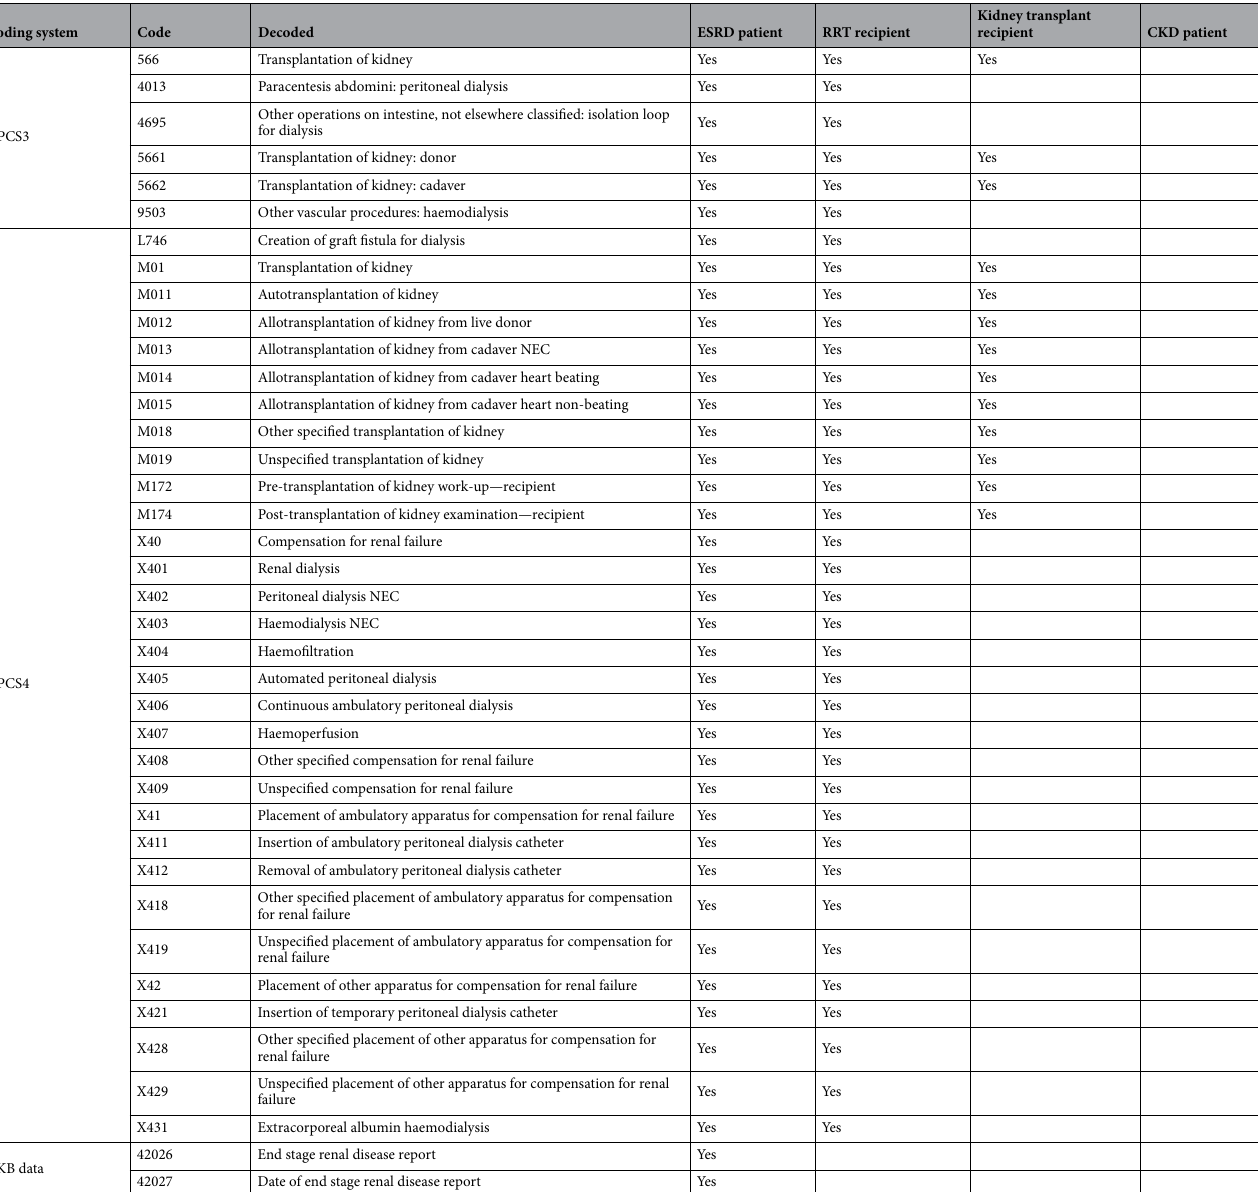
Table 6. Codes included in definitions of ESRD, kidney transplant status, RRT status, and CKD. This shows the various coding systems and codes used to identify subjects with adverse clinical